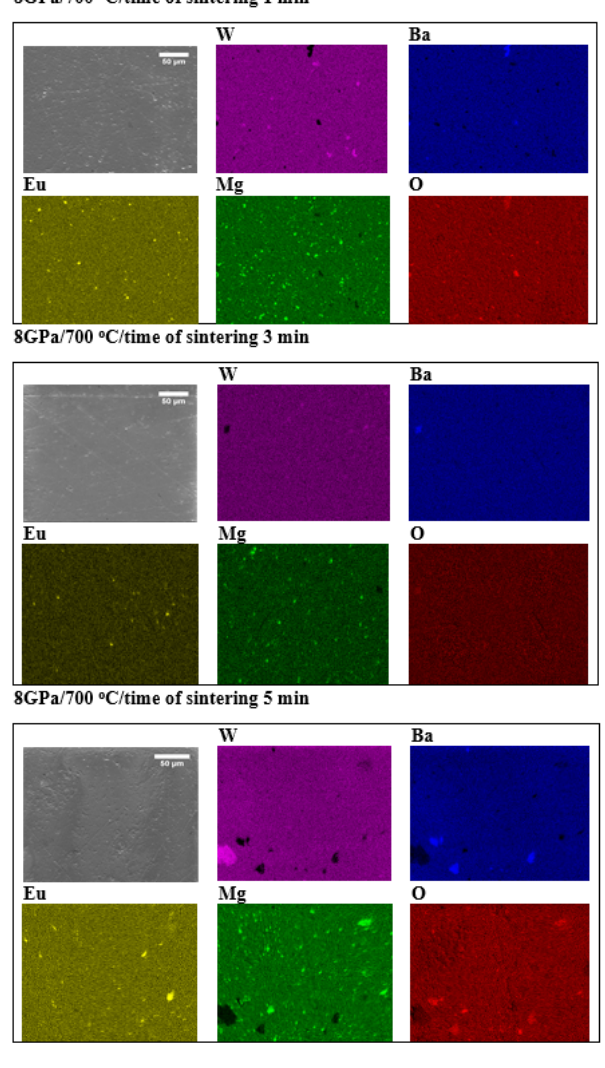
Figure 5. EDS maps of the BMW:Eu-CST ceramic materials (scale 50 µm).